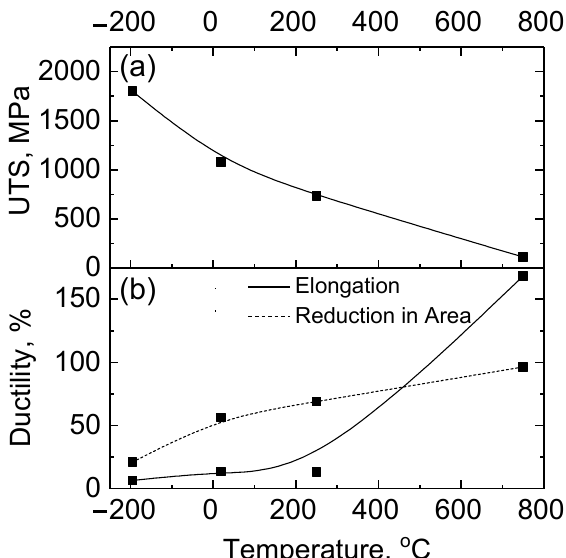
Figure 5. Tensile property of cold-compressed 2Zr-1.2O alloy: ( a ) Ultimate tensile strength (UTS) and ( b ) tensile ductility.